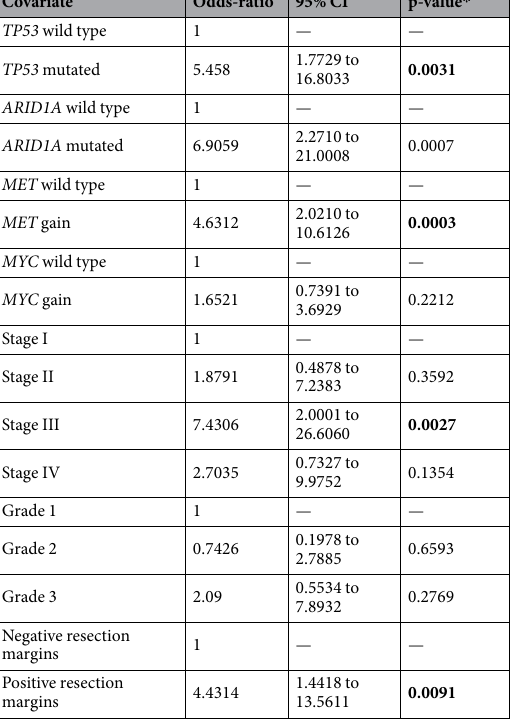
Table 4. Multivariate survival analysis of 66 intrahepatic cholangiocarcinomas; median overall survival was 40.7 months and 41 subjects died of disease. * Cox proportional-hazards regression analysis. Selection of the best model was performed using the “forward”